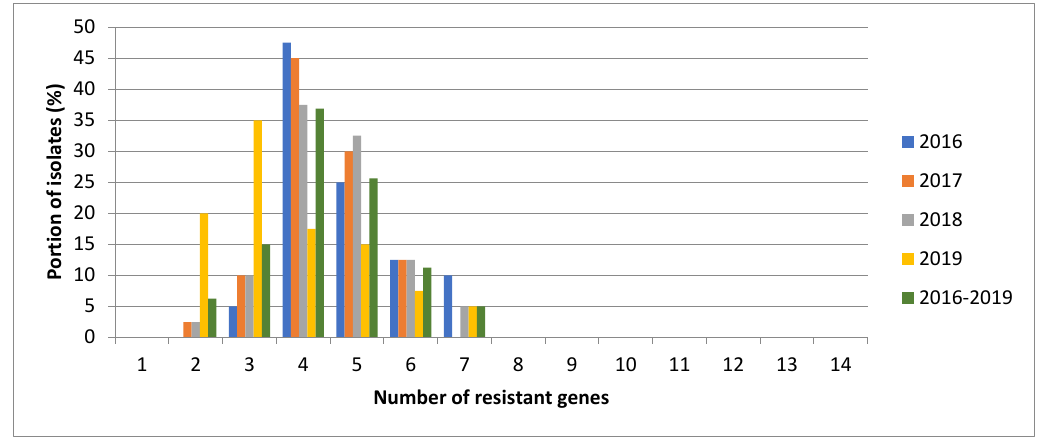
Figure 3. Virulence frequency of the analyzed Bga populations in particular years.